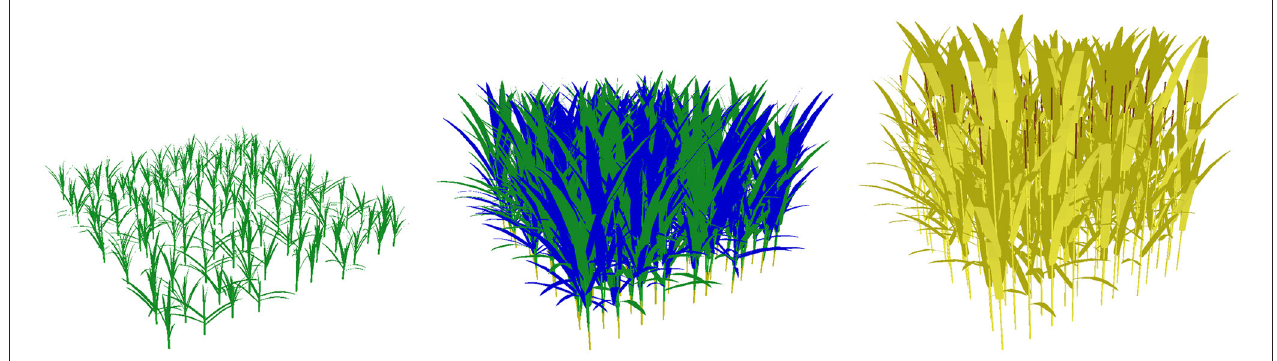
FIGURE 1 | 3D representation of a plot simulated with WALTer, at three different stages of development (from left to right: 100, 200 and 300 days after sowing). The simulated plot is a binary mixture composed of 110 plants sown at a density of 200 plants/m ² . The simulation considers the plot as the pattern of an infinite periodic canopy, removing border effects. Non-senescent organs are represented in green, except for ears that are represented in brown. Regressing tillers are represented in blue and dead organs are represented in